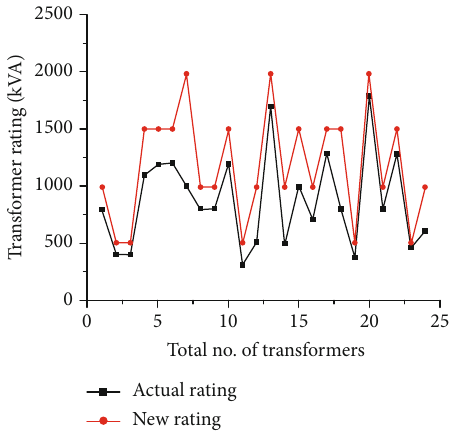
Figure 21: Actual and new ratings of transformers in zone C.